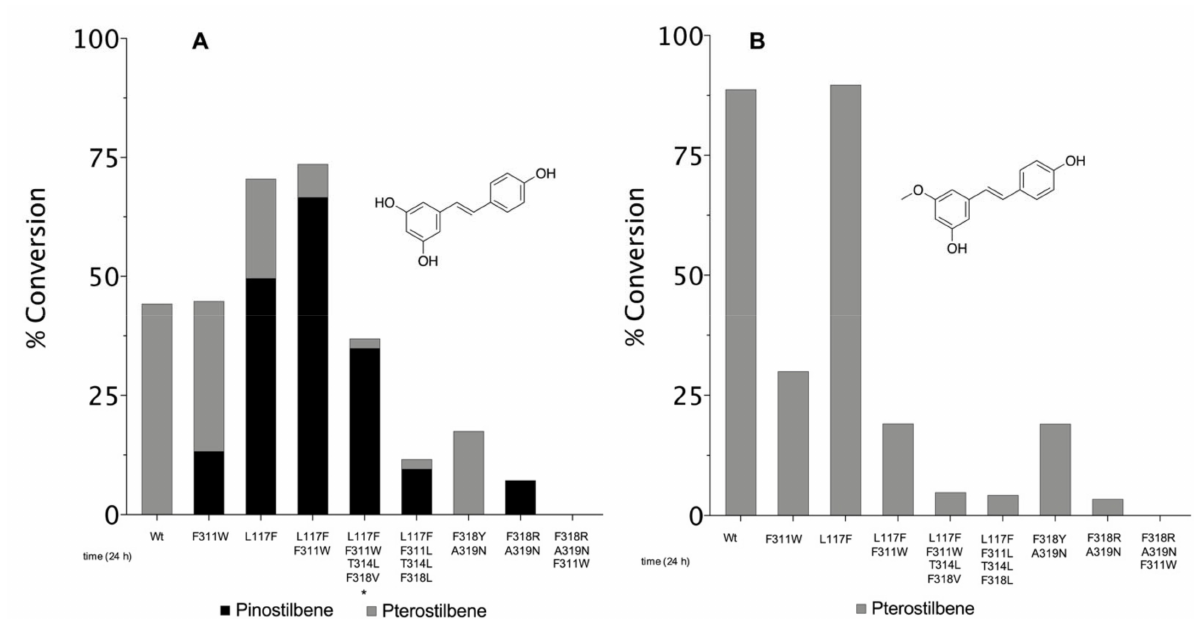
Figure 5. Enzymatic conversion of VvROMT variants. ( A ) Enzymatic reactions started with 350 µ M of resveratrol or ( B ) pinostilbene. Reaction conditions: 5 µ M of purified enzyme and 700 µ M of SAM, incubated in darkness at 30 ◦ C for 24 h and 600 rpm. Reaction products were quantified by HPLC-UV at 306 nm, with a calibration curve using the respective standards. Values represent averages of two replicates. * An undefined product was also observed with this variant.